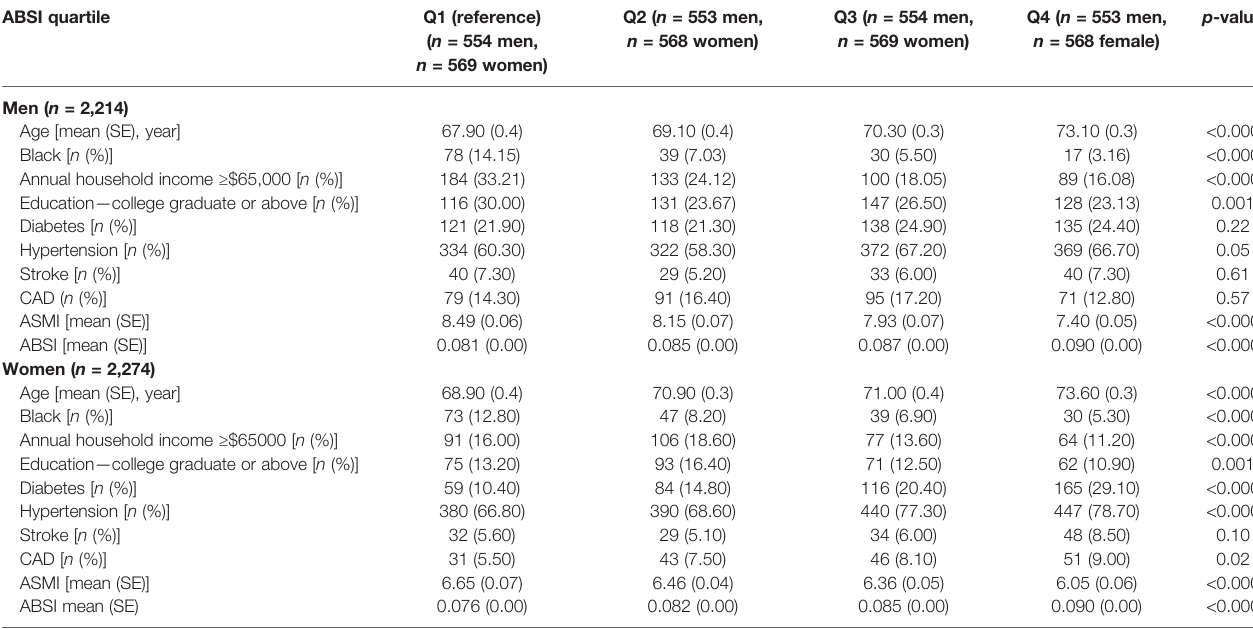
TABLE 1 | Associations between ABSI and risk of all-cause mortality and cause-speci fi c mortality among individuals aged ≥ 60 years ( n = 4,488). ABSI quartile